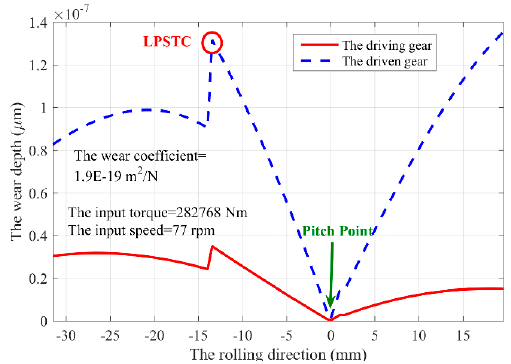
Figure 14. The wear depths of the driving and the driven gear along the LOA [104].